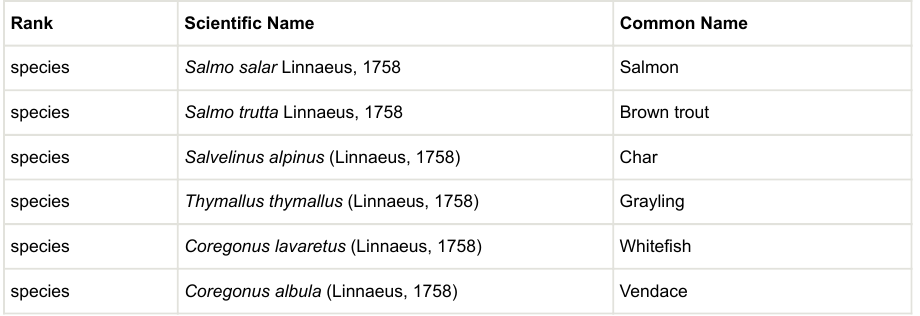
Description: Species cited in literary sources, but not confirmed by our catches, are not considered here. Species rainbow trout Oncorhynchus mykiss and carp Cyprinus carpio have been introduced, the other species are native. Our studies of the water bodies of Murmansk Region revealed the presence of two whitefish Coregonus lavaretus morphs: sparsely rakered and medium rakered. The sparsely rakered whitefish is the most common and can be found in water bodies on its own, while the medium rakered morph is less common and observed only alongside the sparsely rakered one. In general, in sparsely rakered whitefish, the number of gill rakers ranges between 15 and 31, in medium rakered whitefish between 27 and 44. Amongst whitefishes with 27 to 31 gill rakers, both sparsely rakered and medium rakered morphs were observed, distinguishable by the shape of the